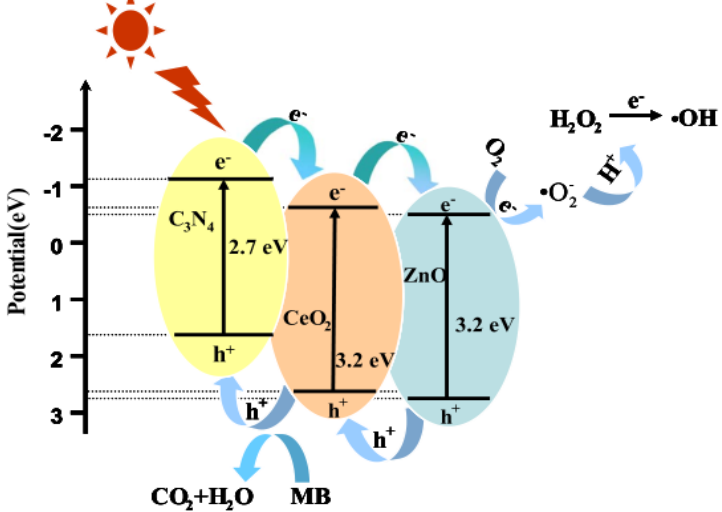
Figure 10. Schematic diagram of the photoexcited e − /h + separation process in the Schematic diagram of the photoexcited e − /h + separation process in the g- g − C 3 N 4 /CeO 2 /ZnO composite under visible − light irradiation. Used with permission from [137]. C 3 N 4 /CeO 2 /ZnO composite under visible-light irradiation. Used with permission from [137]. Copyright 2017 Elsevier. Copyright 2017